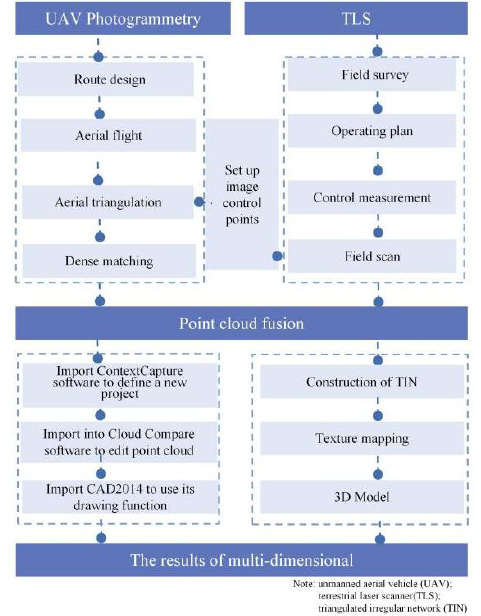
Figure 2 . The workflow and process of data collection.